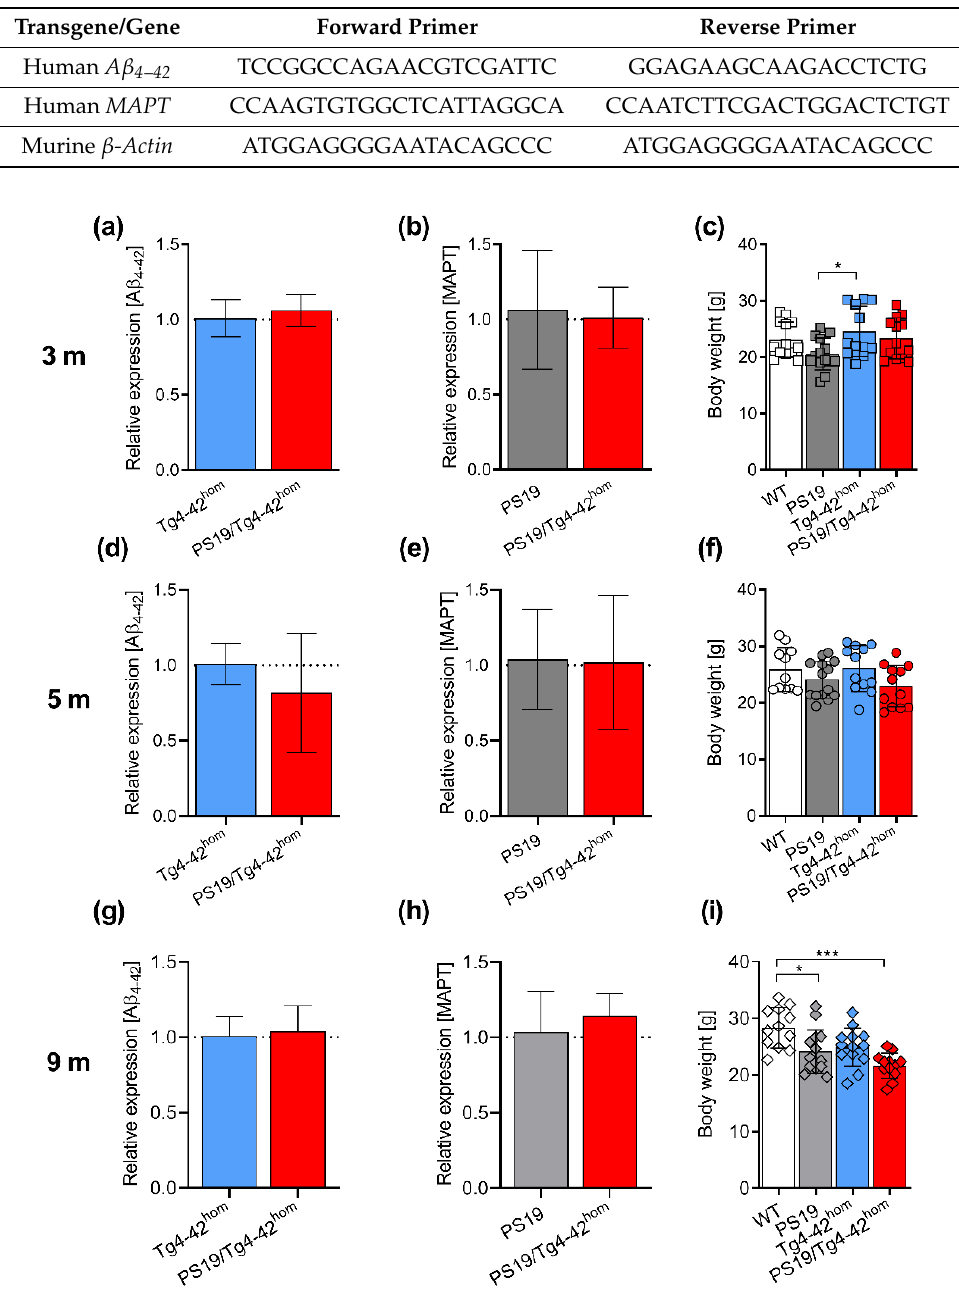
Table 1. Sequences of Forward and Reverse primers and probes used in qRT-PCR analyses.